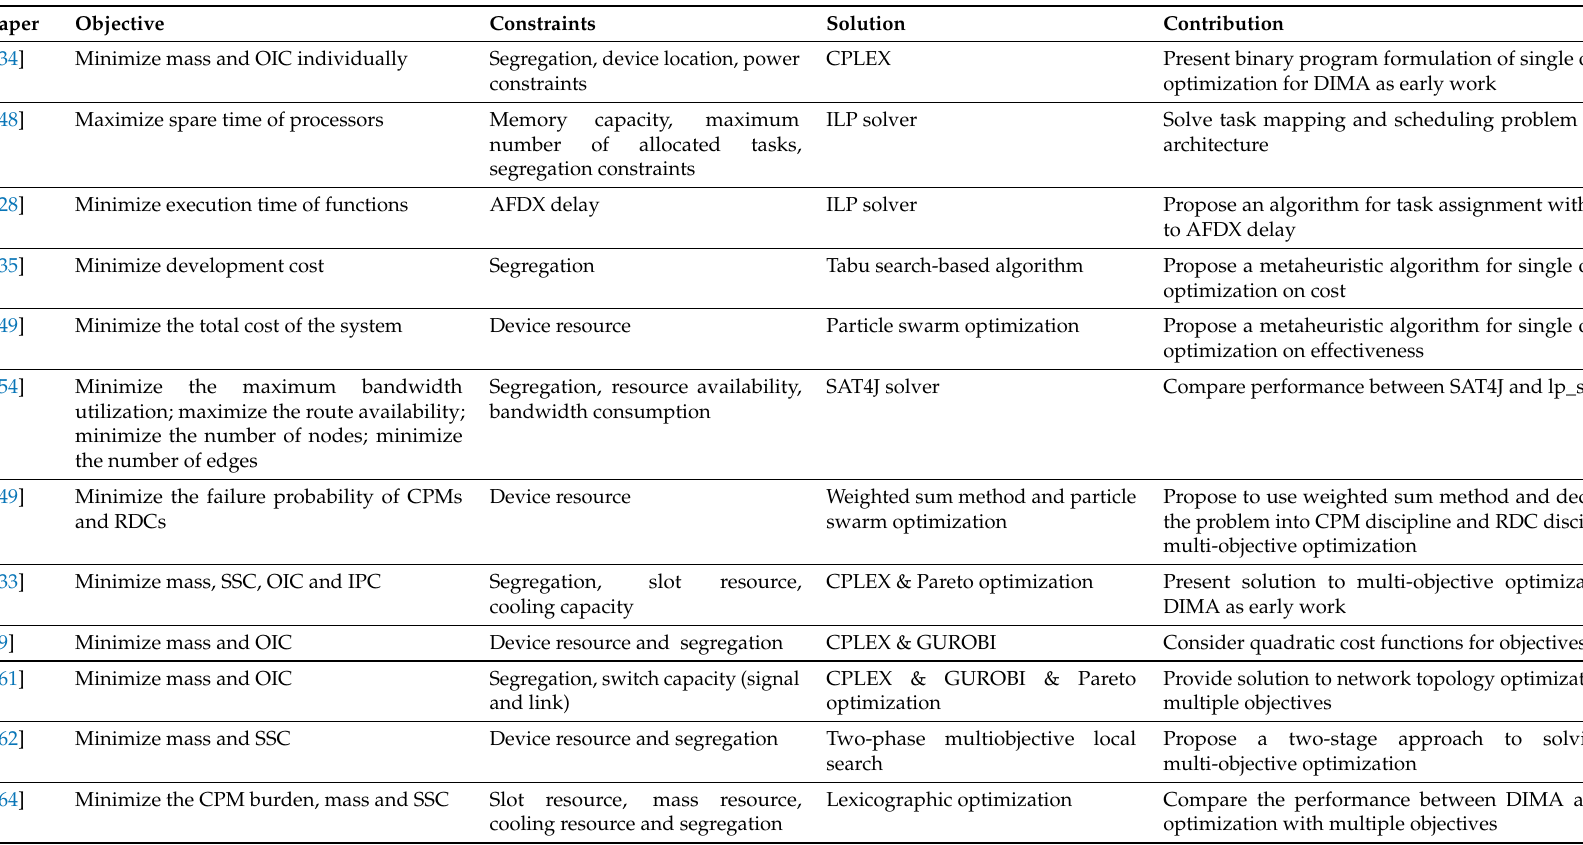
Table 2. A list of previous work on Distributed Integrated Modular Avionics (DIMA) optimization is summarized based on their objectives, constraints, solution and